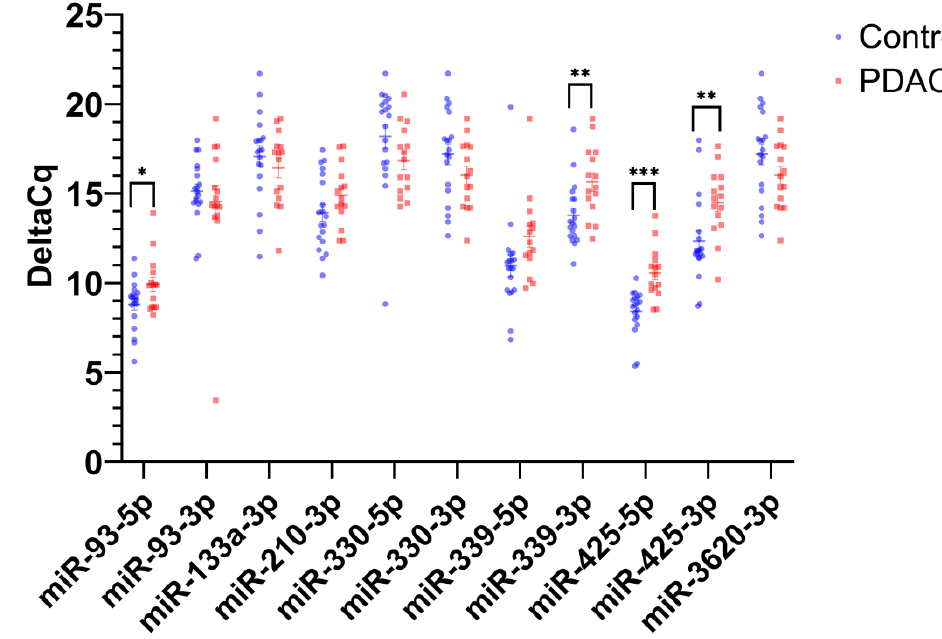
Figure 1. Exosomal miRNA expression levels in PDAC patient plasma compared to control. The scatterplot shows the average ΔCq values for 11 mature miRNAs in PDAC samples ( N = 15) and control samples (N = 19). Student’s t -test was used to establish significance, where *, **, and *** denote p < 0.05, p < 0.01, and p < 0.001, respectively.